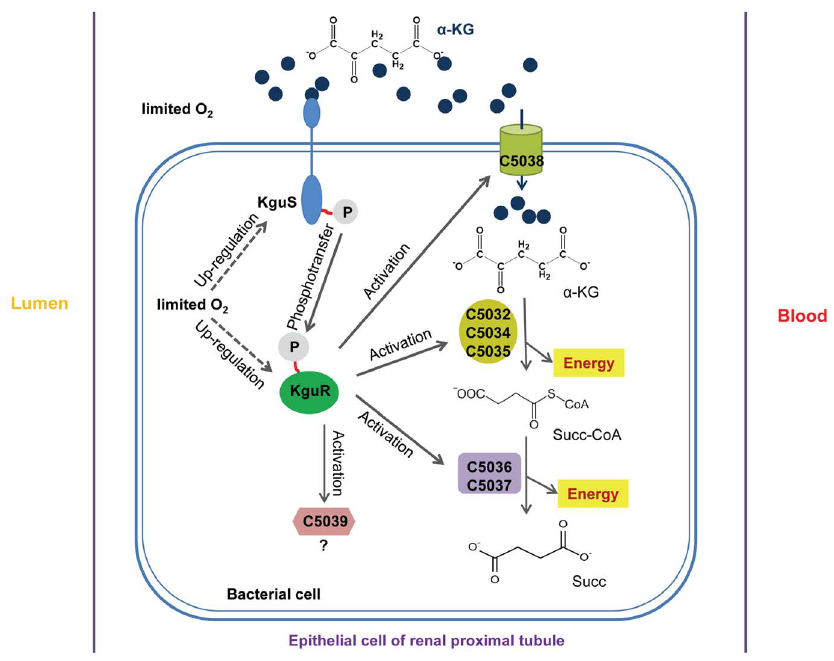
Figure 9. A schematic model for the regulatory mechanism of C5041/C5040 and its controlled target genes. In certain host environments of UPEC, such as the epithelial cells of renal proximal tubule, where oxygen tension is low and a -KG is abundant, KguS/KguR can sense and respond to these stimuli by activating the expression of c5038 encoding dicarboxylate transporter and c5032 - 5037 genes encoding metabolic enzymes, involved in the utilization of a -KG as carbon and energy source. Possession and functionality of this system may meet special metabolic needs for UPEC during urinary tract infections. Question mark indicates function is unknown. Blue dots, a -KG ( a -ketoglutarate); Succ-CoA, succinyl- CoA; Succ,